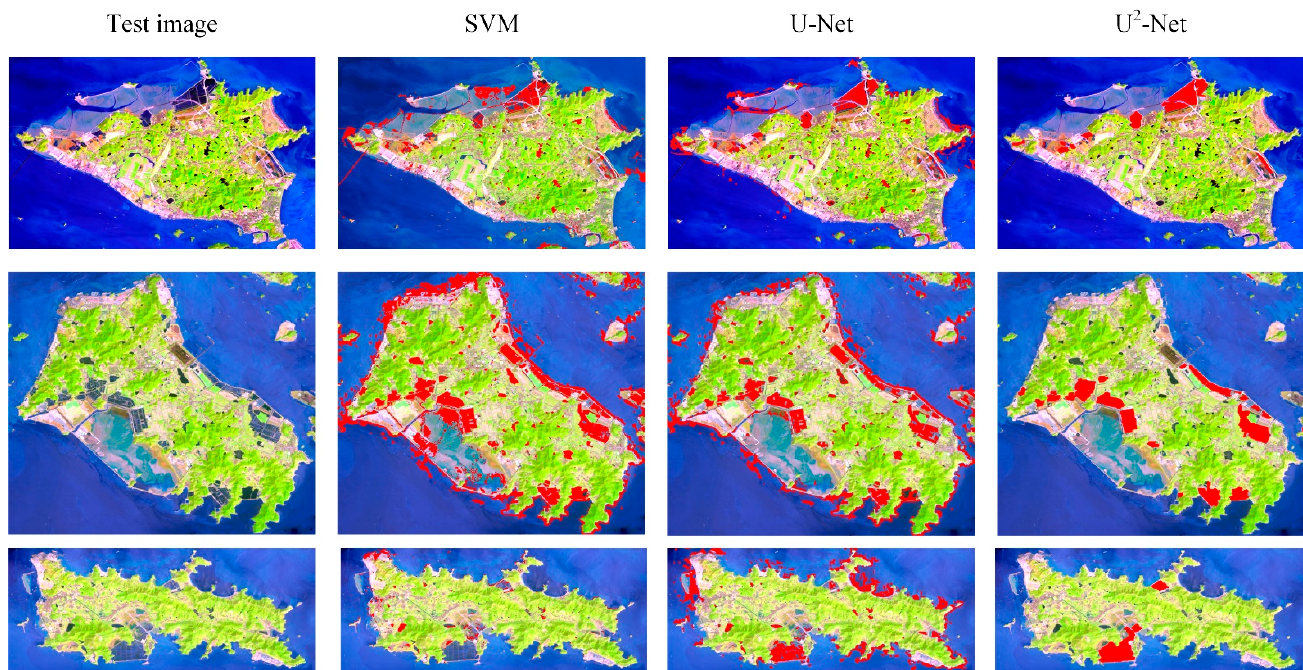
Figure 13. The extraction results using the SVM-based method, U-Net deep learning model-based method, and the U 2 -Net deep learning model-based method, and the red area represents the coastal aquaculture ponds. Table 6. Accuracy evaluation of the SVM-based method, U-Net deep learning model-based method, and U 2 -Net deep learning model-based method, and the best value is represented in bold.